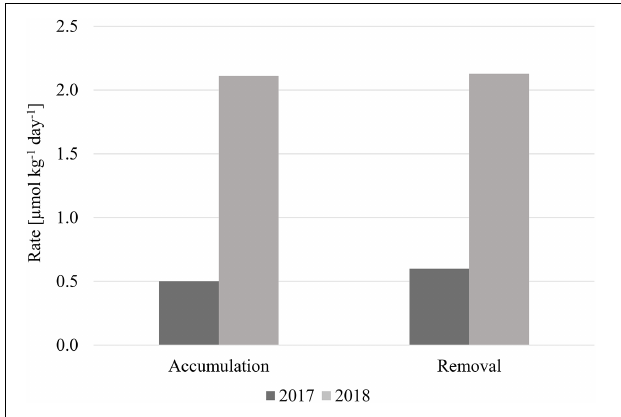
FIGURE 8 | Rates of net seasonal TOC accumulation and removal [ µ mol kg − 1 day − 1 ] for 2017 and 2018.